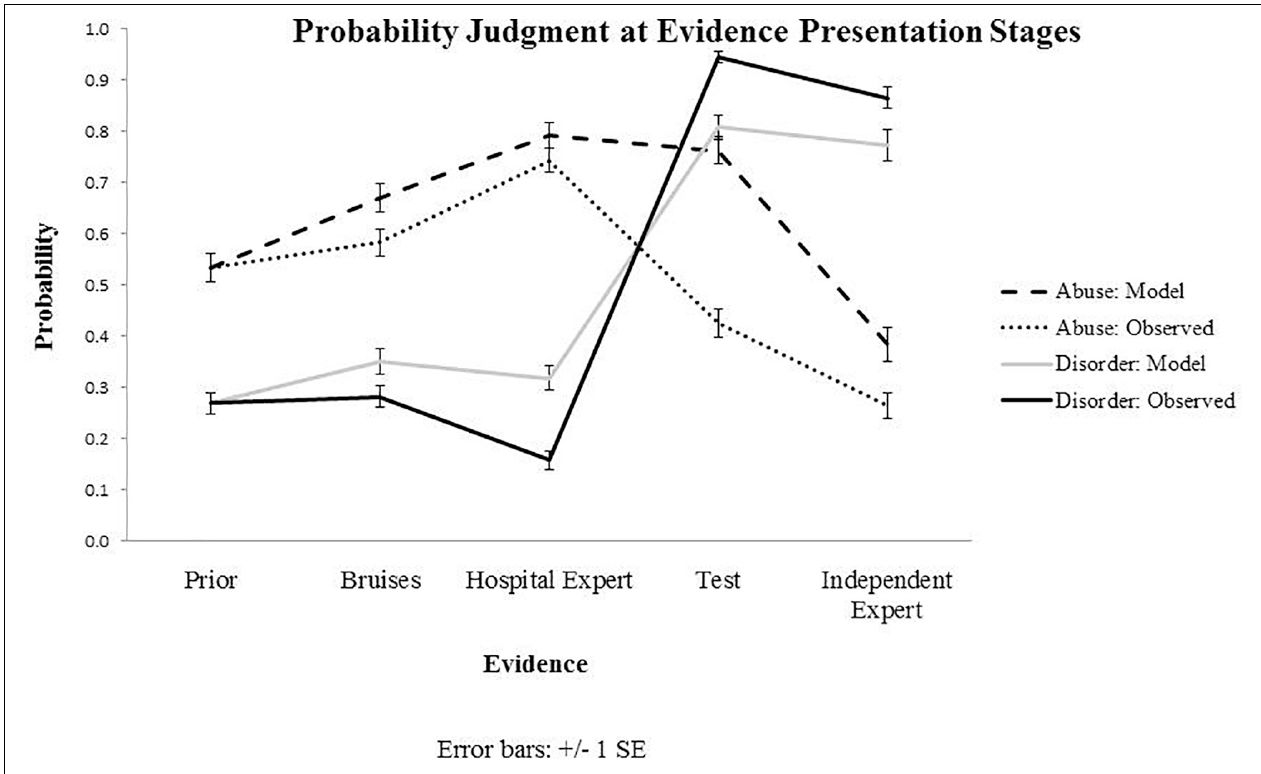
FIGURE 2 | Results from Experiment 1: Observed and predicted (model) probability judgments at each evidence presentation stage, starting with prior beliefs and capturing belief updating following the evidence about bruises, hospital expert report, blood test results and independent expert report. Priors presented on the graph for both observed and predicted values represent subjective priors set by the